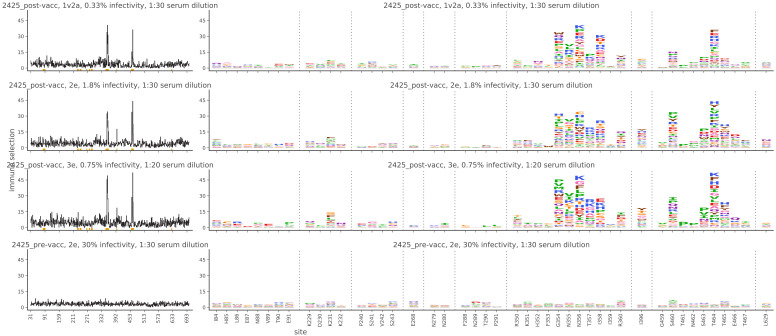
Mutational antigenic profiling data plotted for each individual replicates of pre- and post-immunization sera from rabbit 2425.Data are plotted as in Figure 2A,B for each, but with mutations colored according to their biochemical property rather than epitope.